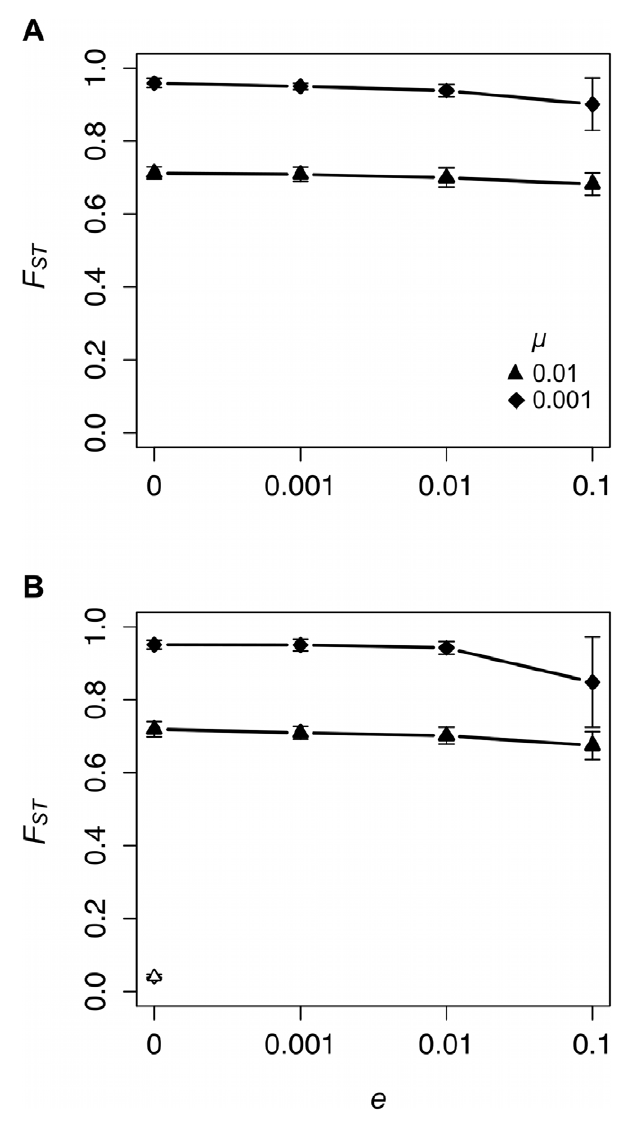
Figure 5. Local extinction rate ( e ) affects group differentiation as measured by F ST under equilibrium (A) and non-equilibrium (B) conditions. Each data point provides the mean 6 1 standard deviation of 20 unique simulated populations. Black symbols represent data collected from populations with unbiased cultural transmission and white symbols data collected from populations with conformist cultural transmission. doi:10.1371/journal.pone.0015582.g005 P , 0.001 and m = 0.01: x 2 =19.28, P , 0.001) conditions. In our model, higher rates of local extinction constrain differentiation among groups as measured by F ST . Figure 6 summarizes the (cid:2) dd G results for metapopulations simulated over different values of m and e . In general, (cid:2) dd G increases with m . In addition, e has a significant effect on (cid:2) dd G for all levels of m tested ( m =0.00001: x 2 = 65.67, P , 0.001; m =0.0001: x 2 = 62.12, P , 0.001; m = 0.001: x 2 =66.19, P , 0.001; m = 0.01: x 2 = 66.69, P , 0.001). As was the case with F ST , the (cid:2) dd G results show that there is less differentiation between groups in metapopulations plagued by a higher frequency of local extinctions (Figure 6). In short, the model predicts that group differentiation as measured by the mean distance between modal variants would decrease as the frequency